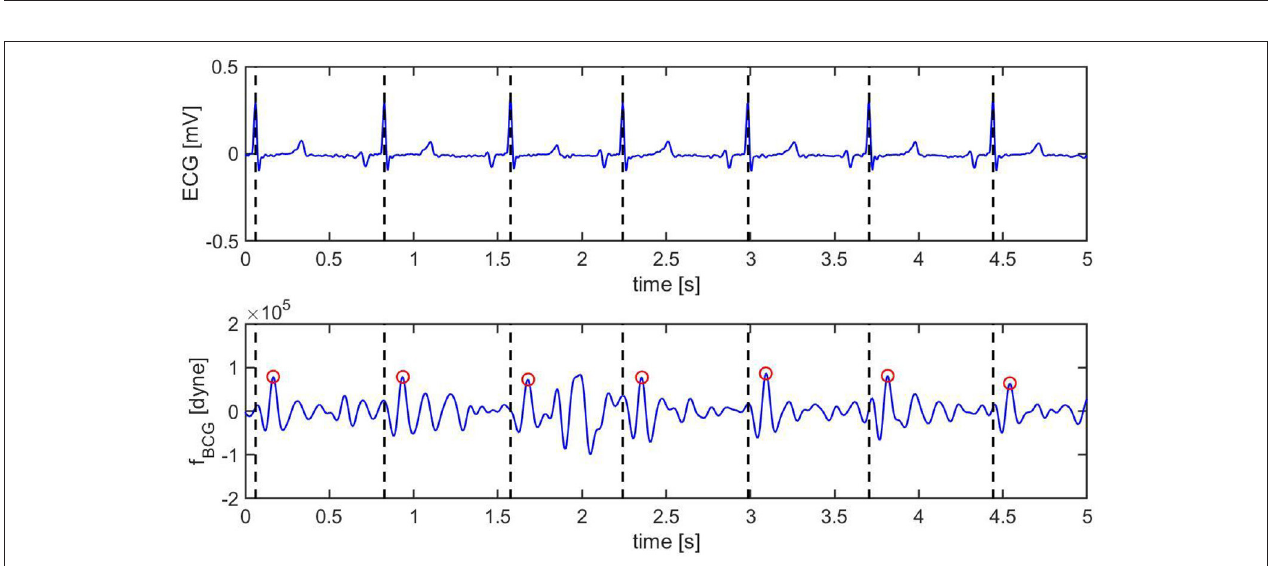
FIGURE 7 | Model-predicted BCG waveforms f A for different values of the ELS parameter. The vertical dashed lines represent the beginning of the systole and the circles indicate the J peaks in the BCG.